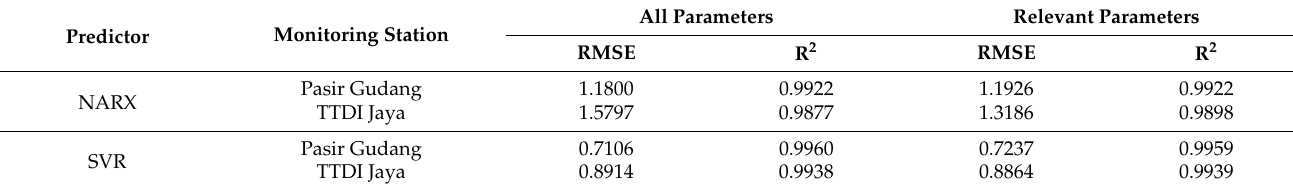
Table 3. The RMSE and R 2 for all and relevant parameters.